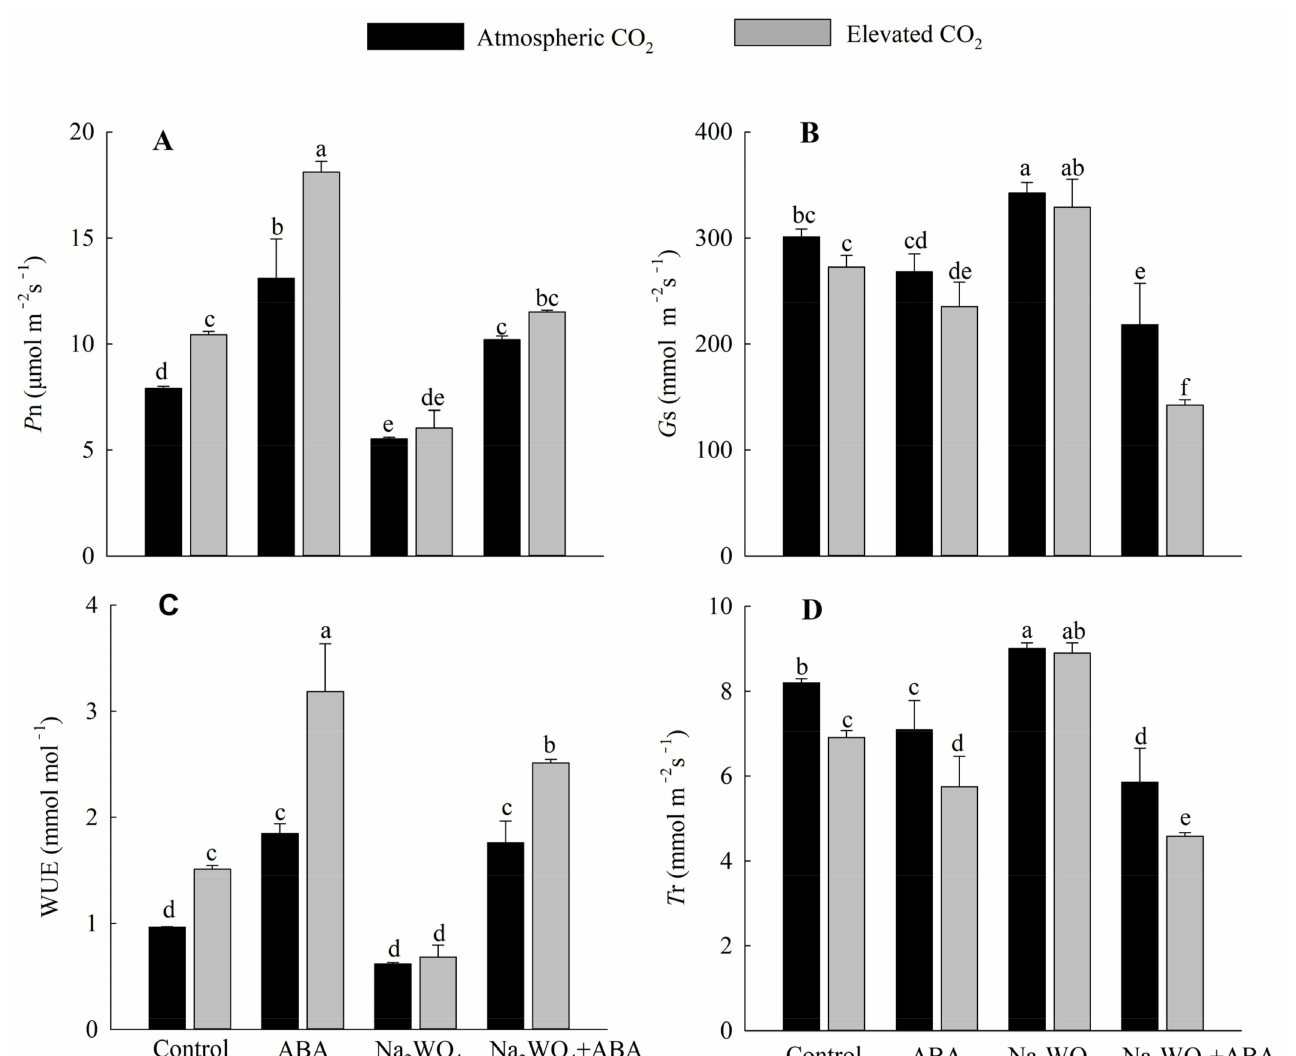
Figure 2. Effects of elevated CO 2 and exogenous ABA on net photosynthetic rate ( A ), stomatal conductance ( B ), water use efficiency ( C ), and transpiration rate ( D ) in leaves of cucumber seedlings under drought stress. Different lowercase letters represent significant differences between treatments at the 0.05 level. Values were the means ± SD (n =